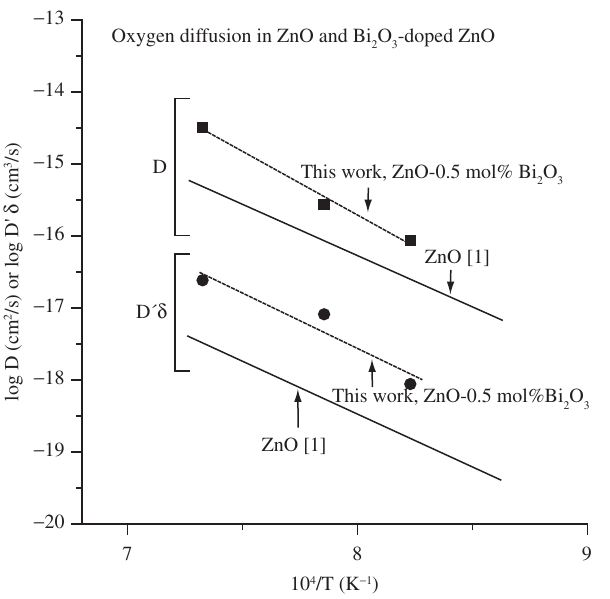
Figure 4. Arrhenius plot for oxygen diffusion in undoped ZnO and in ZnO- 0.5 mol % Bi